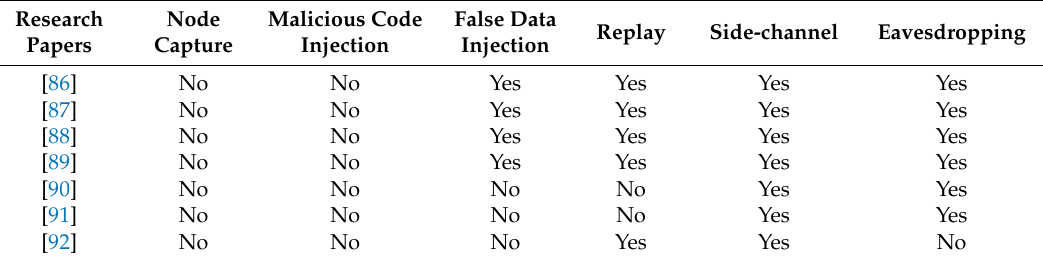
Table 5. Attacks on asymmetric based encryption schemes.